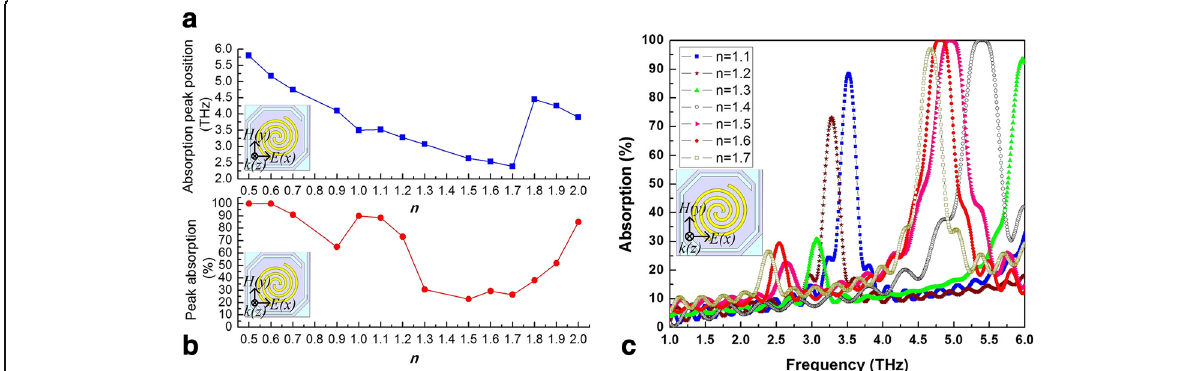
Fig. 2 Variation curves of absorption peak position ( a ) and peak absorption rate ( b ) and THz wave absorption curves ( c ) of micro-bridge structures with different rotation angles (360* n ) of spiral-type antennas on the support